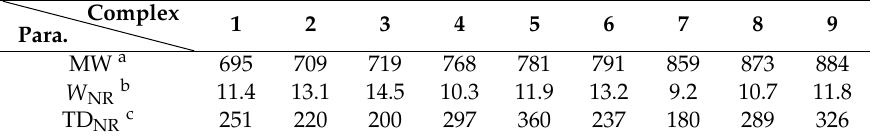
Table 2. Thermal gravimetric analysis (TGA) Data of Complexes 1 – 9 . Para.